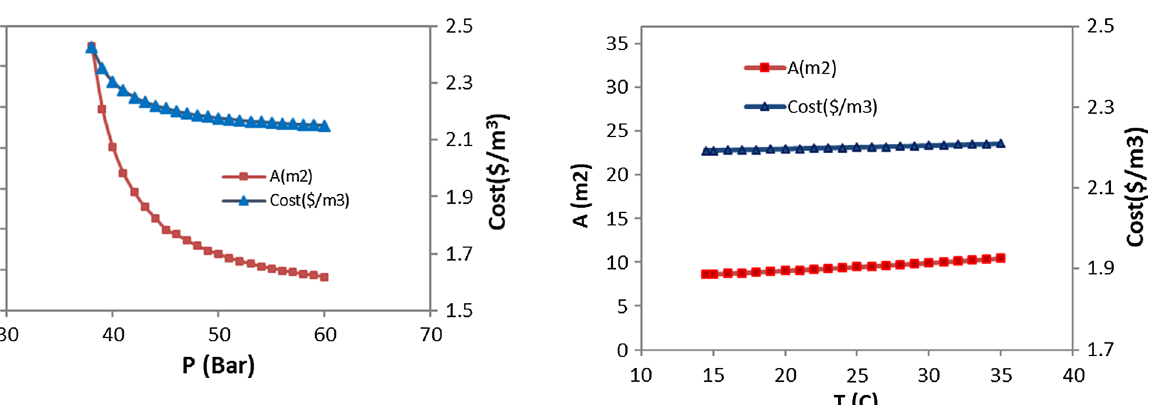
Modeling the changes of the temperature versus cost and the active area of the membrane